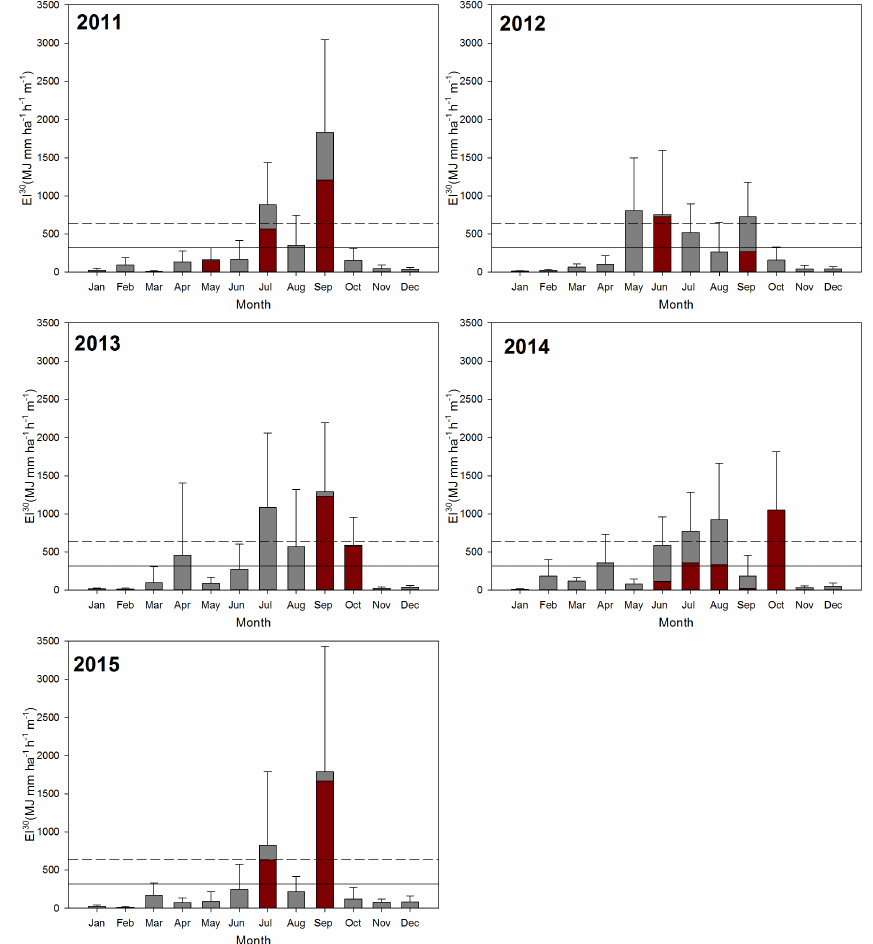
Figure 9. Total (grey) and typhoon-related (red) monthly rainfall erosivity from 2011 to 2015 with the mean line representing mean monthly rainfall erosivity and the dashed line being 1 standard deviation from the mean for the period of 1995–2015 for the 42 rainfall stations